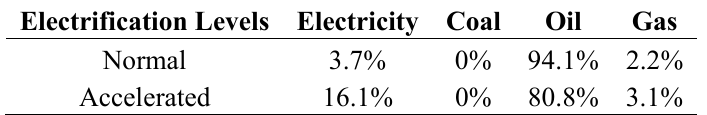
Table 5. Shares of different energy forms in transport demand by